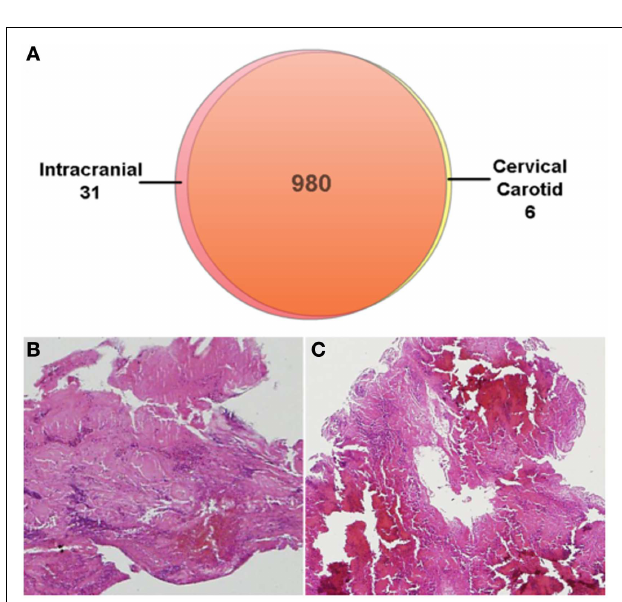
FIGURE 4 | Contrast-enhanced MRA obtained 24h after stroke onset demonstrates final angiographic result with patent left cervical carotid and middle cerebral arteries (A) . Post-intervention 24h followup